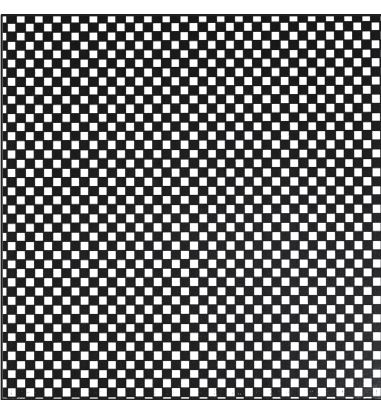
Figure 18. Checkered pattern to be observed.